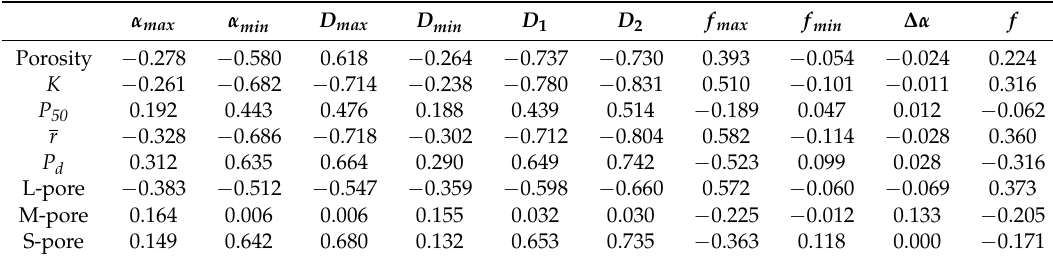
Table 5. The correlation coefficients between multifractal parameters and pore structure parameters.